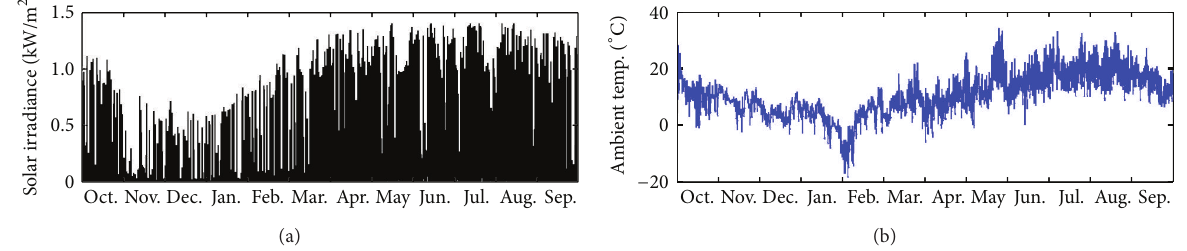
Figure 3: A yearly mission profile used for the selected transformerless PV inverters (1sec/sample): (a) solar irradiance and (b) ambient temperature.